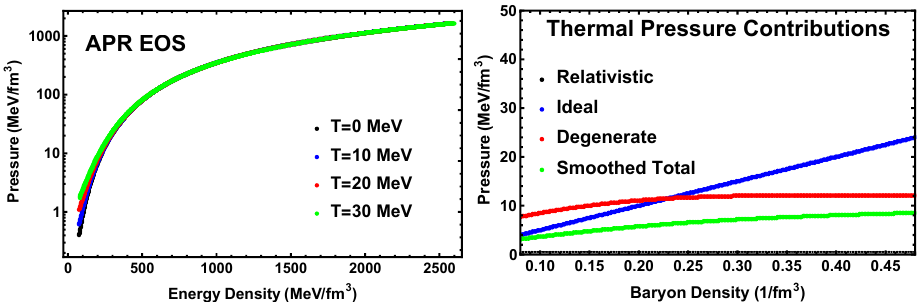
Figure 2. ( Left panel ) The APR EOS with thermal contributions included as per the parameterizations in [12]. ( Right panel ) Thermal effects are most pronounced in the low-density regime (0.05–3.0) n sat and are thus expected to inflate the radius of the hot neutron star relative to a cold one. This is proportionate to the impact of thermal effects, shown here for a temperature T = 50 MeV, on lifting the degeneracy of dense matter. Corresponding results for the ZL EOS are qualitatively